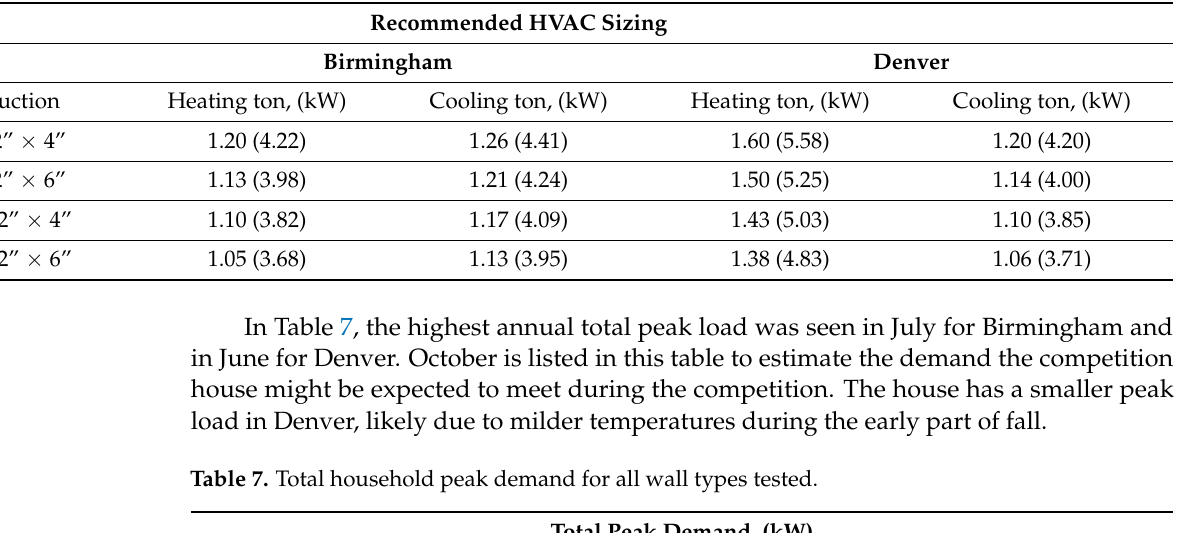
Table 6. Recommended HVAC unit sizing for differing wall structures.